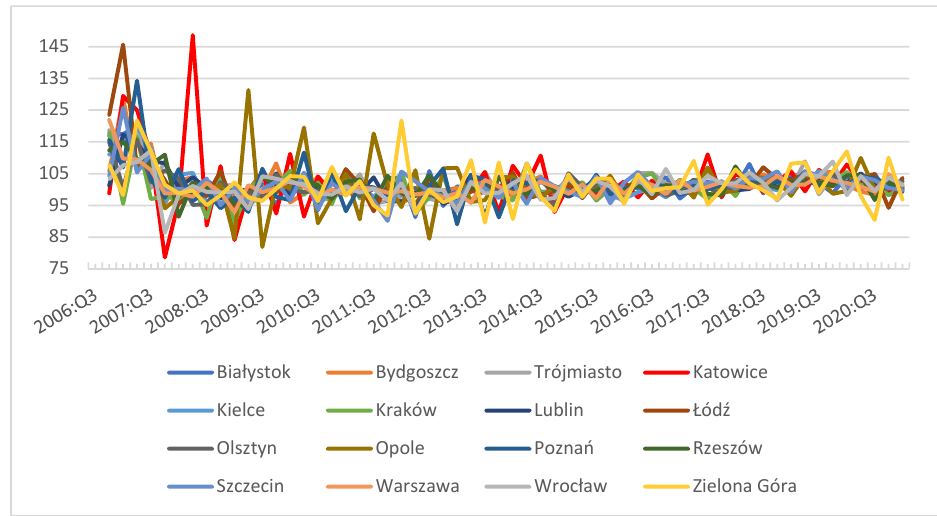
Figure 2. Hedonic price index (q-o-q). Secondary market—16 cities.